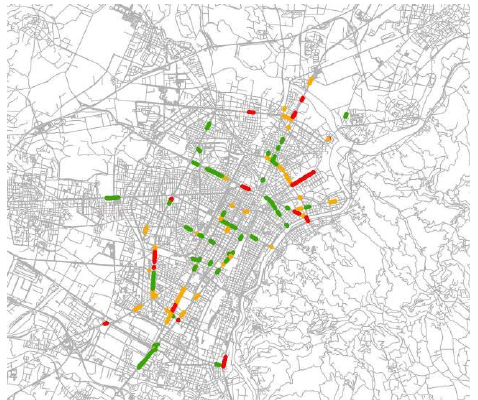
Figure 10. Comparison between sensor data and FCD (green = lower differences, red = higher differences)